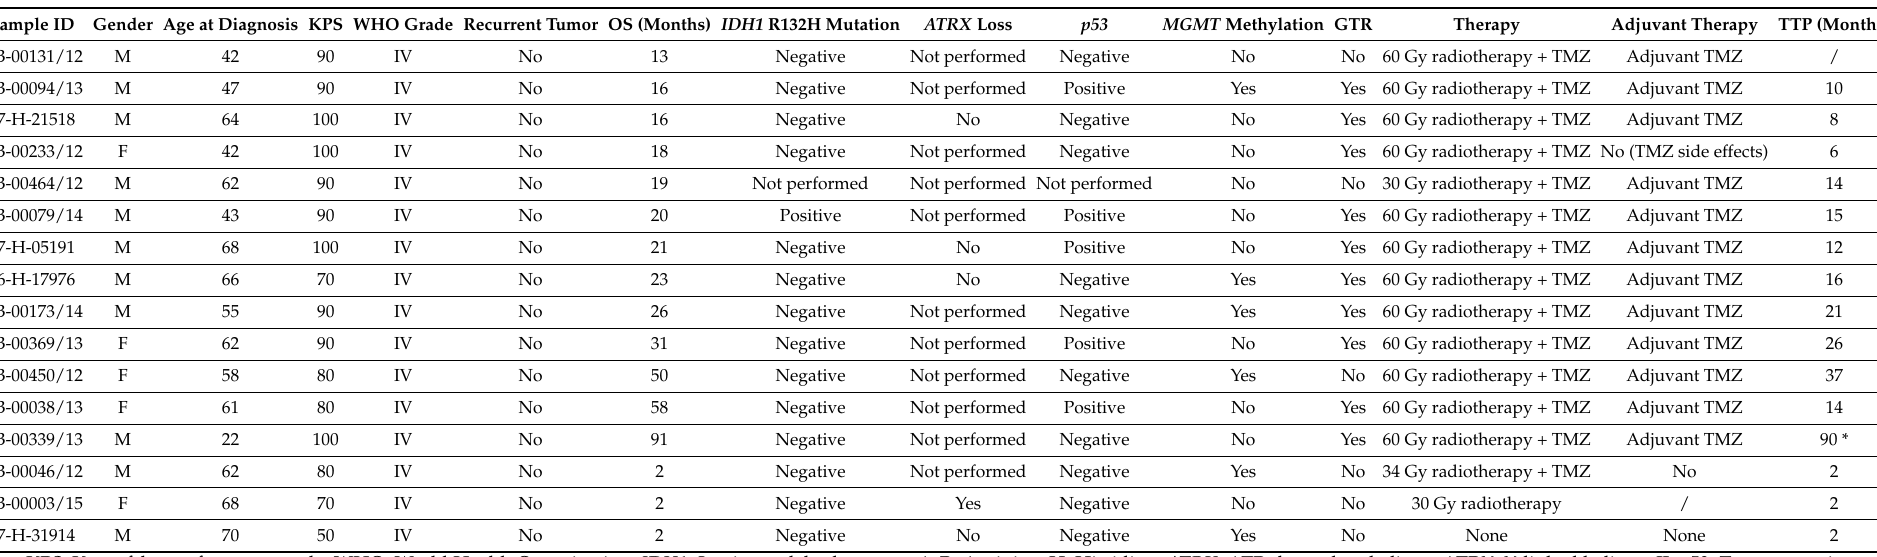
Table 1. Clinicopathological information about experimental glioblastoma patients involved in this